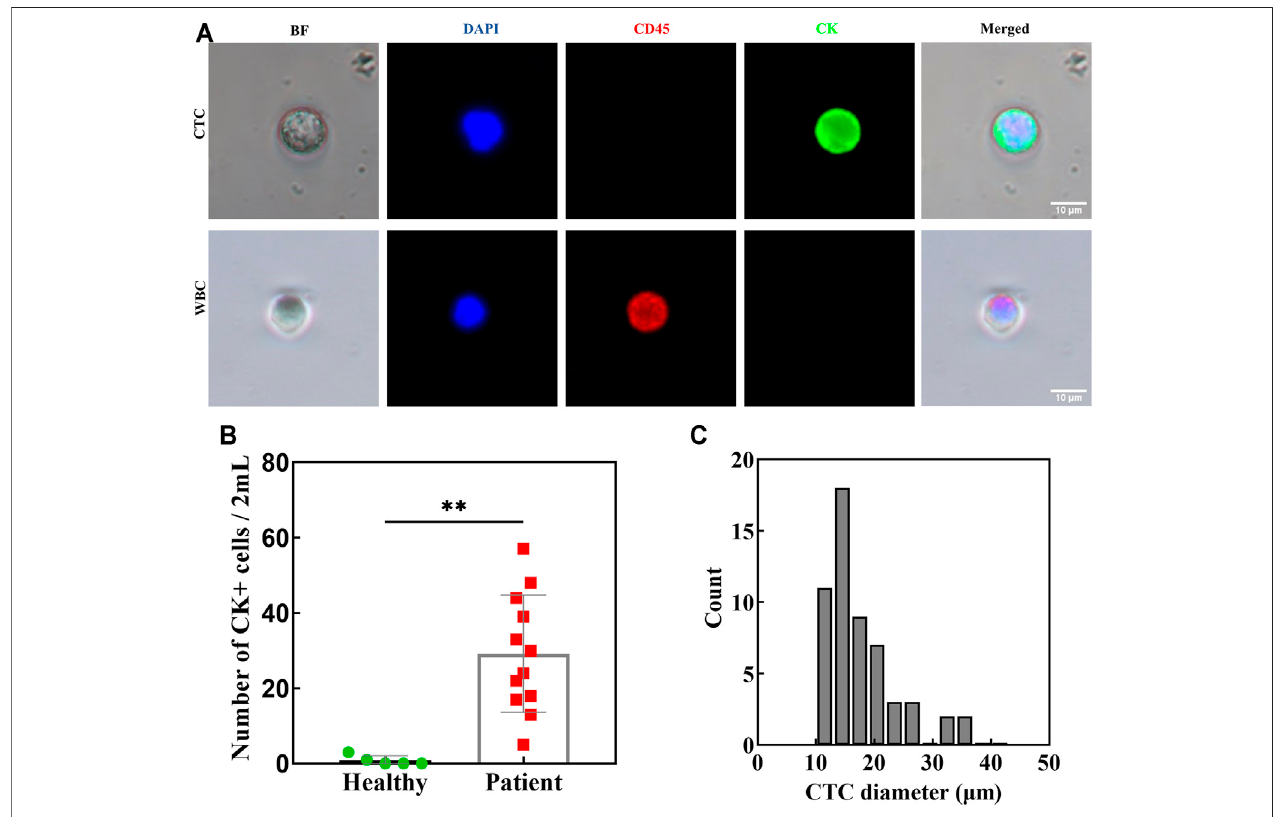
FIGURE 6 | Blood from patients with lung/breast cancer ( n (cid:2) 12) and healthy donors ( n (cid:2) 5) was processed using a double spiral chip. (A) Immuno fl uorescence staining of isolated cells. (B) CK positive cells in both patients and healthy as indicated. ** p < 0.05. (C) The diameter and the corresponding number of isolated CTCs in